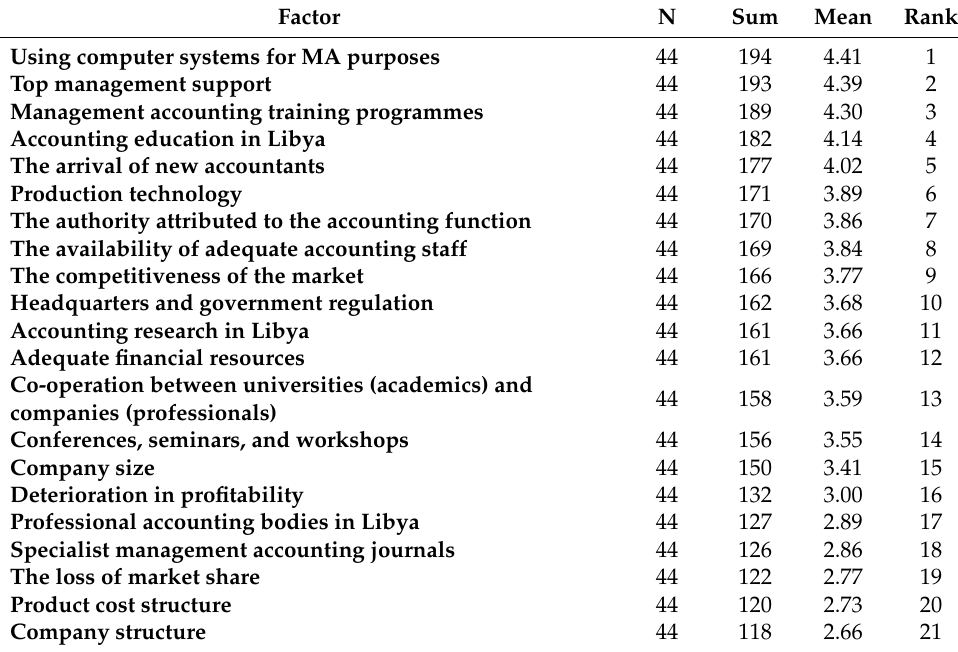
Table 7. Contextual factors for the adoption of MAIs in the manufacturing sector. Factor N Sum Mean Rank Using computer systems for MA purposes